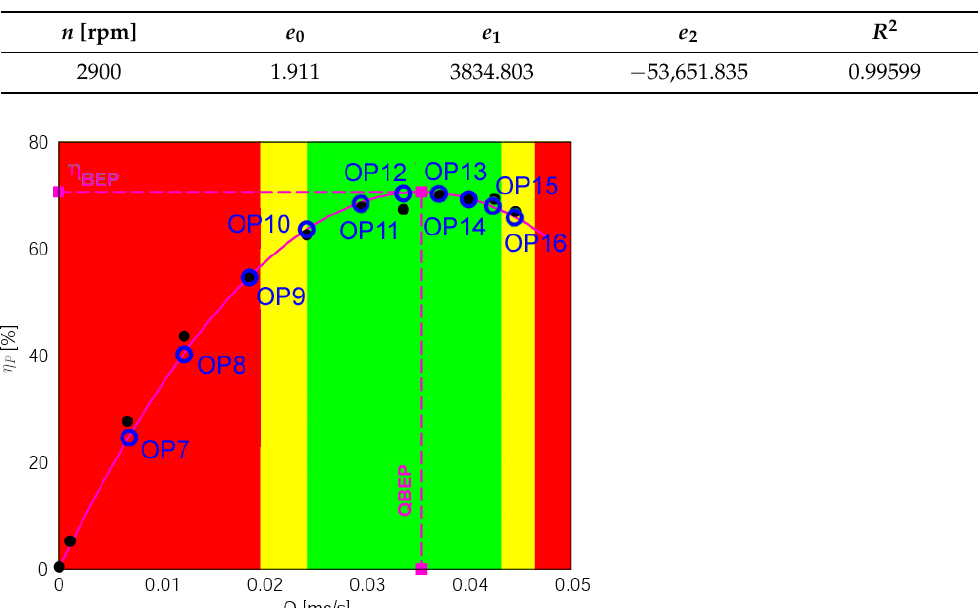
Table 4. The coefficients of the 2nd-degree approximation polynomial function for the pump efficiency η P = f ( Q ) at speed of 2900 rpm.